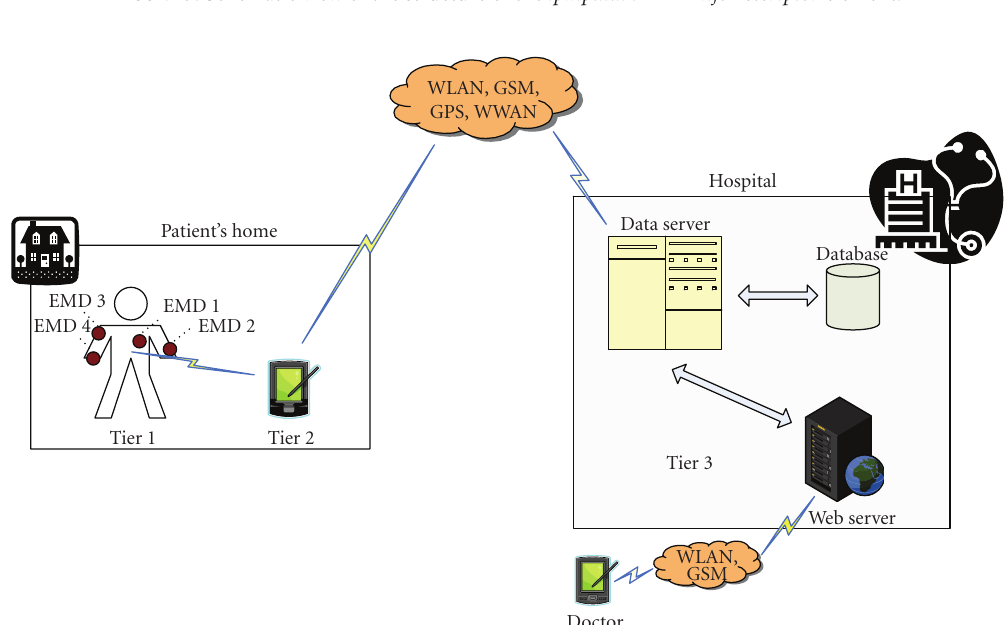
Figure 4: A high-level view of the proposed